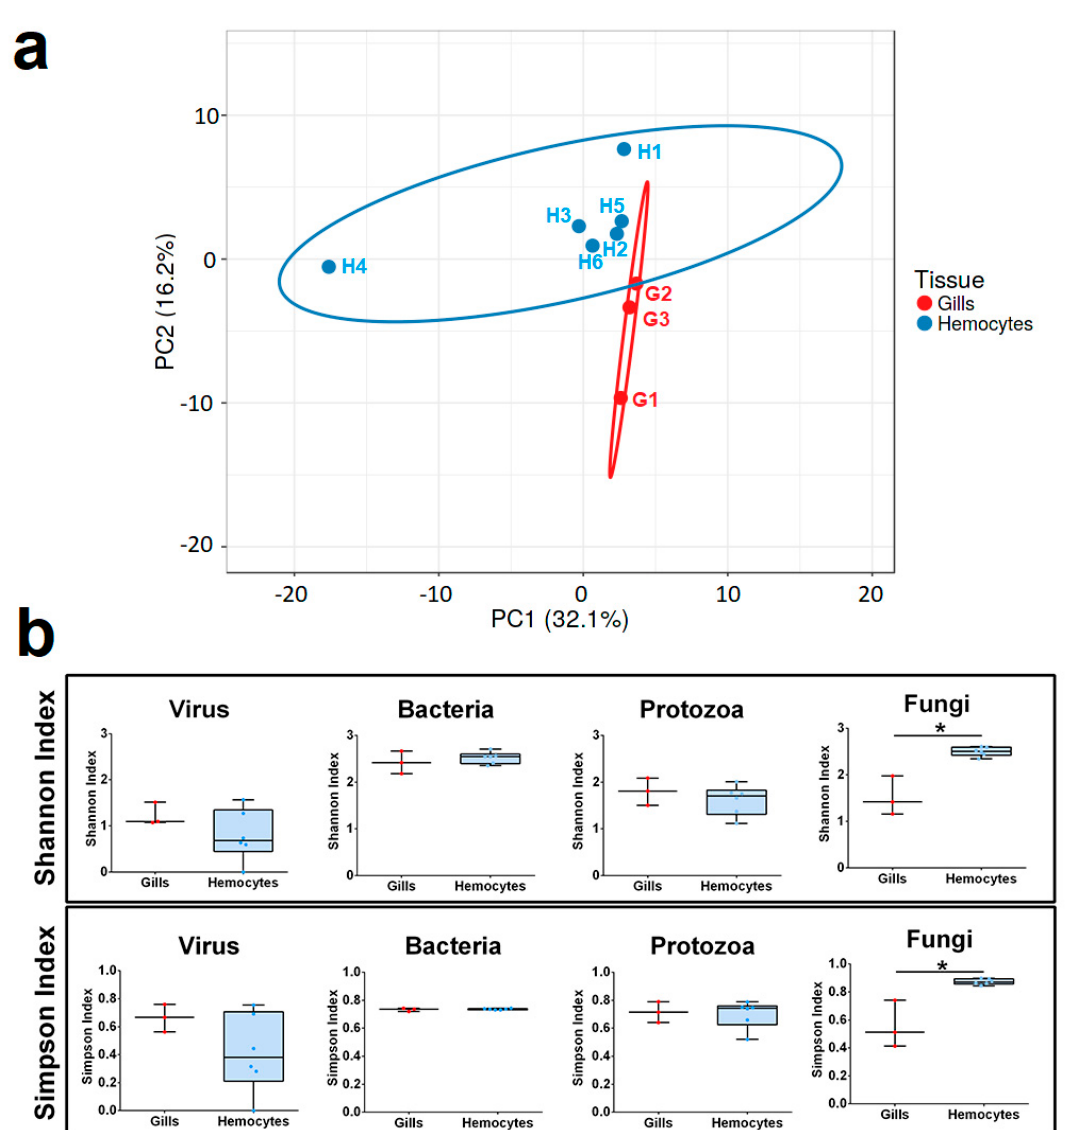
Figure 5. ( a ) PCA describing the dataset containing taxa (all the analysed groups) abundance in the gills and haemocytes of M. galloprovincialis . ( b ) Shannon entropy and Simpson’s indexes of viruses, bacteria, protozoa, and fungi in the gills and haemocytes of M. galloprovincialis . * indicates a p value < 0.05 after the Mann ‒ Whitney U test.